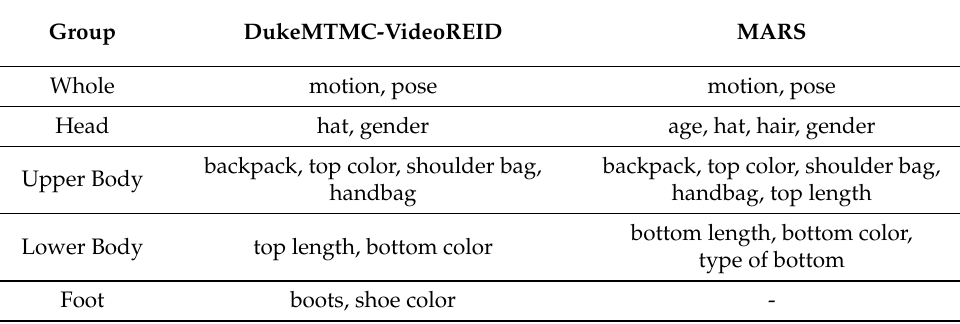
Table 1. Attribute groups for DukeMTMC-VideoReID and MARS datasets. Group